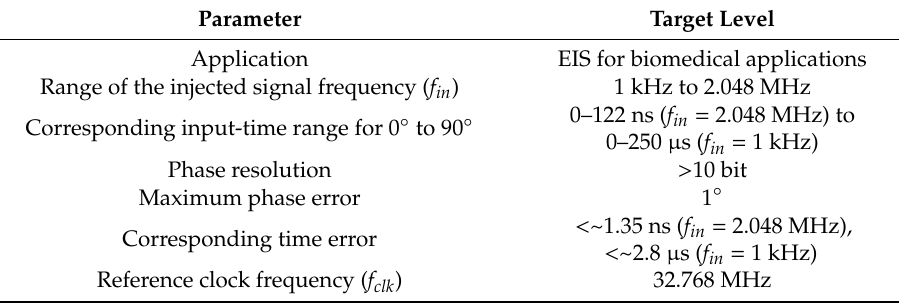
Table 1. Design specifications of the proposed time-to-digital converter (TDC).